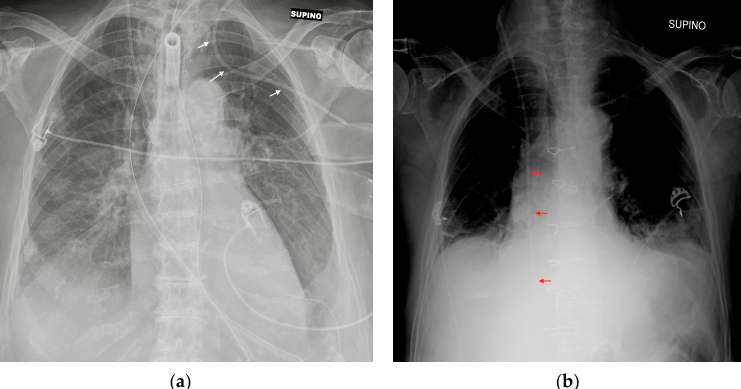
Figure 3. Mispositioned CVCs. ( a ) Left jugular-inserted CVC with its tip inside the left axillar vein (white arrows). ( b ) Right jugular CVC with its tip inside IVC (red arrows). Note that due to underexposure during acquisition of the CXR, the tip of the catheter is hard to see in the upper abdomen.